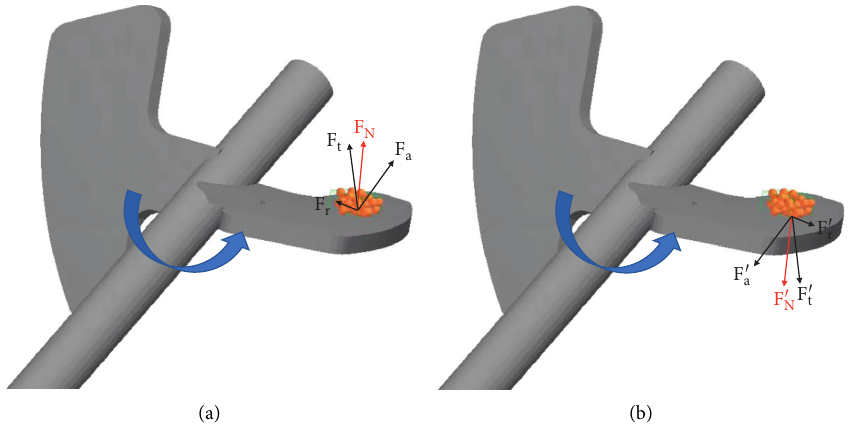
Figure 21: The force analysis of the concrete particles’ unit (a) and the blade unit